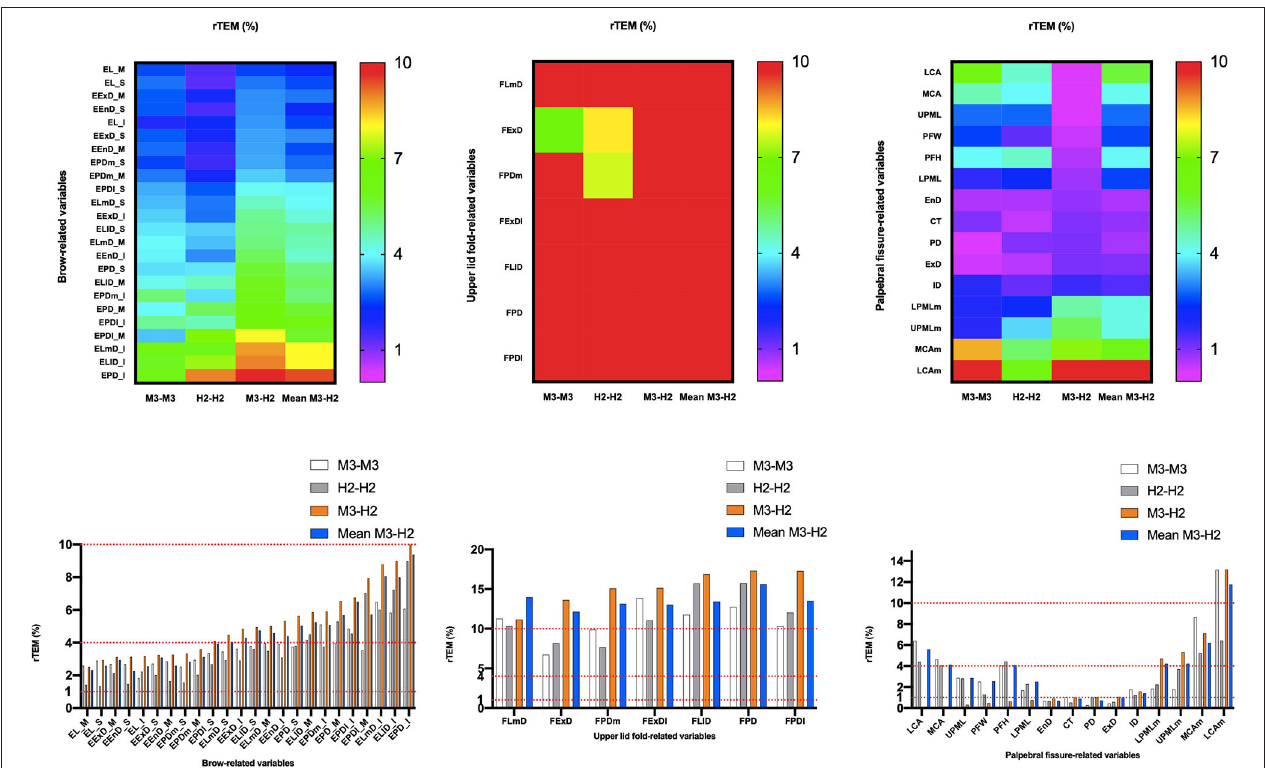
FIGURE 6 | Intra- and inter-device of relative technical error of measurement (rTEM) for all periocular region measurements of 3D images. Reliability category criteria were as follows: excellent, < 1%; very good, 1–3.9%; good, 4–6.9%; moderate, 7–9.9%; and poor, >